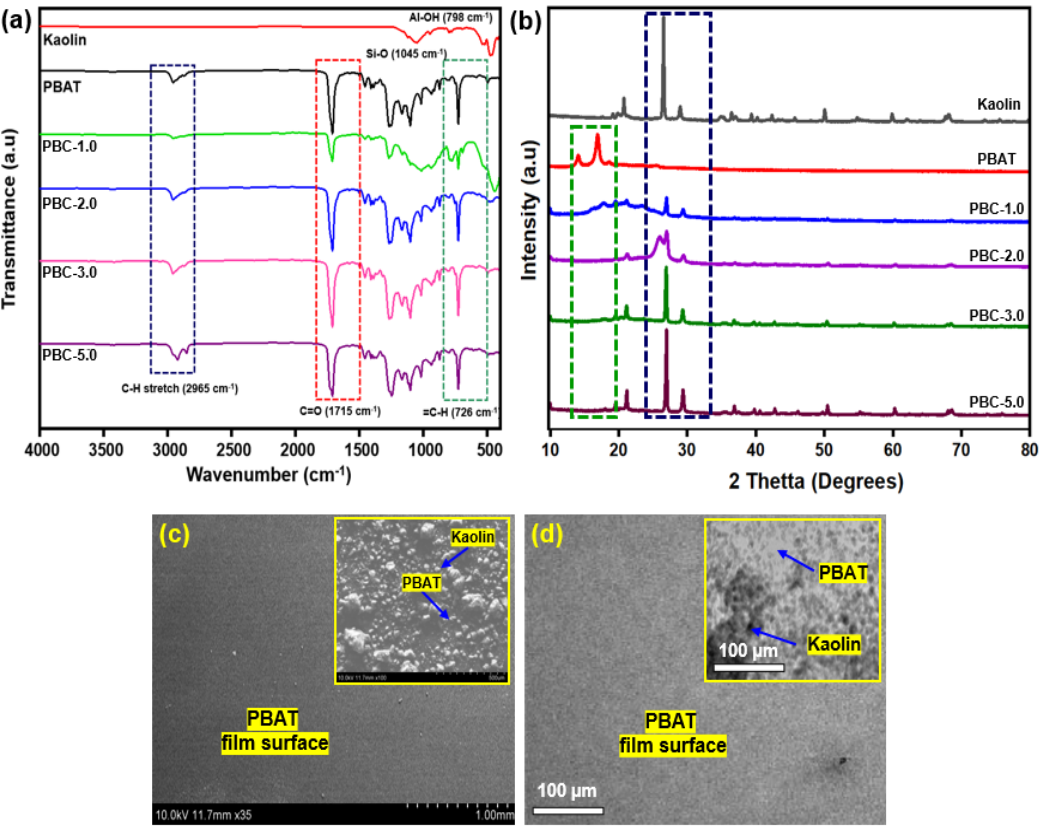
Figure 2. Characterizations of the microstructure and morphology of PBAT/kaolin composites: ( a ) FTIR spectrum; ( b ) XRD; ( c ) SEM image; PBC - 5.0 film insets of ( c ); ( d ) TEM image of PBAT and ( a ) FTIR spectrum; ( b ) XRD; ( c ) SEM image; PBC-5.0 film insets of ( c ); ( d ) TEM image of PBAT and PBAT/kaolin biocomposites (insets ( d )). PBAT/kaolin biocomposites (insets ( d